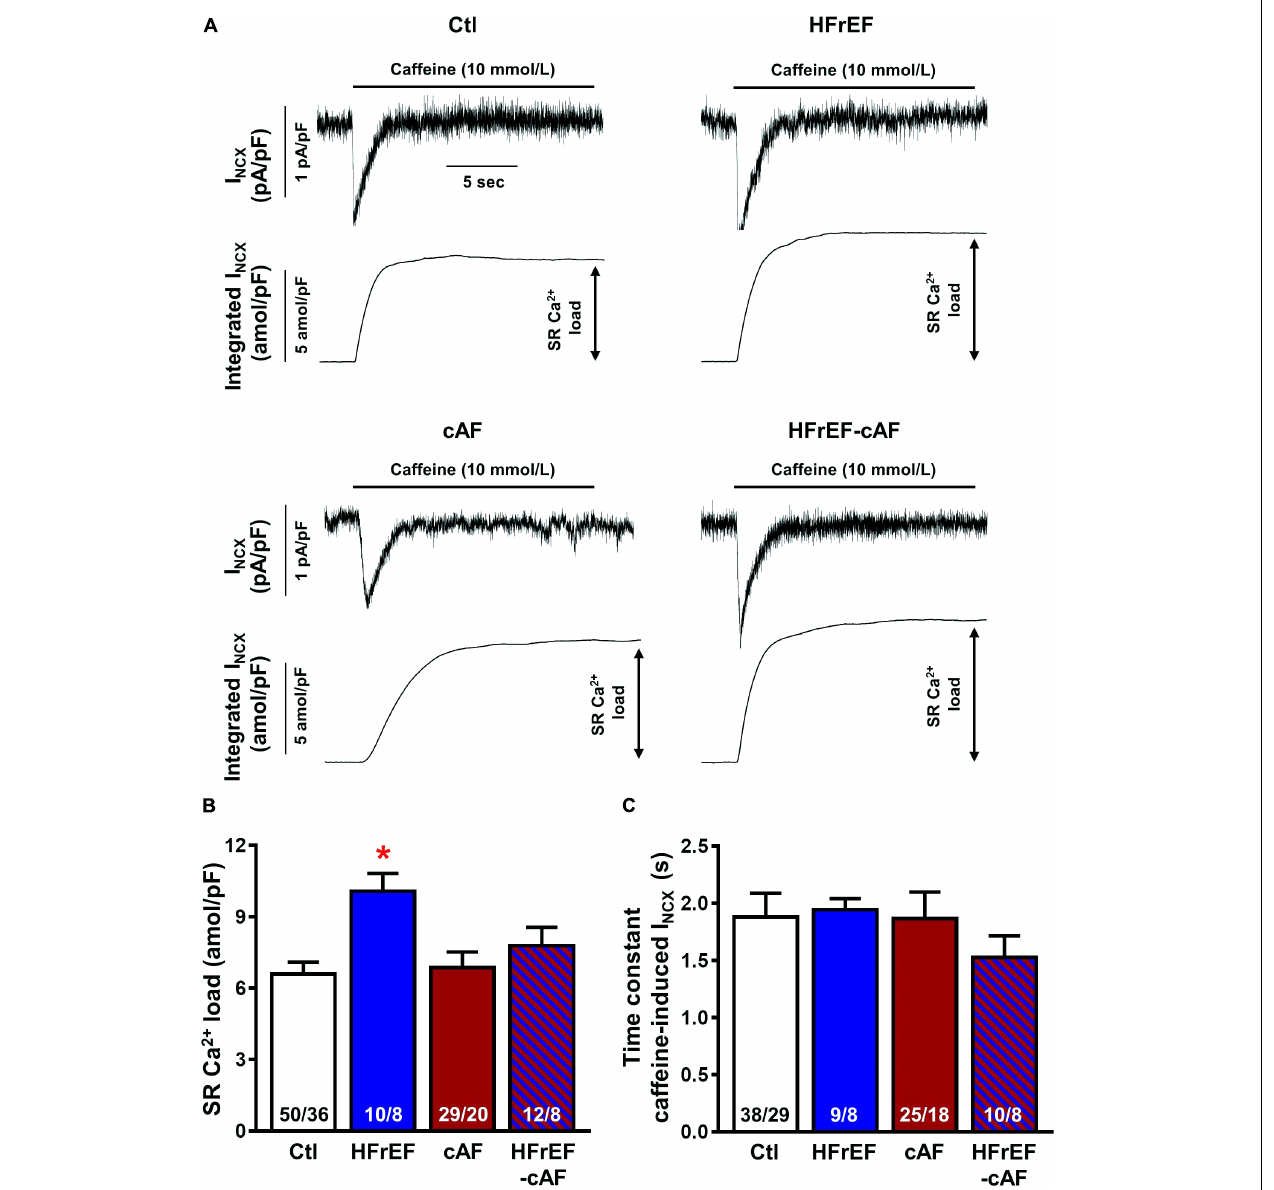
FIGURE 5 | Sarcoplasmic reticulum (SR) Ca 2 + load in isolated human atrial cardiomyocytes. (A) Representative recordings of NCX-mediated inward current (I NCX ) induced by caffeine (10 mmol/l) application in atrial cardiomyocytes from Ctl, HFrEF, cAF or HFrEF-cAF patients (top panels). The bottom panels show the integral of membrane current over time, the amplitude of which is an accepted index of SR Ca 2 + load. (B,C) SR Ca 2 + load (B) and time constant of caffeine-induced I NCX (an indicator of NCX function) in the four groups. Numbers in bars indicate number of cells/number of patients. ∗ indicates P < 0.05 vs.